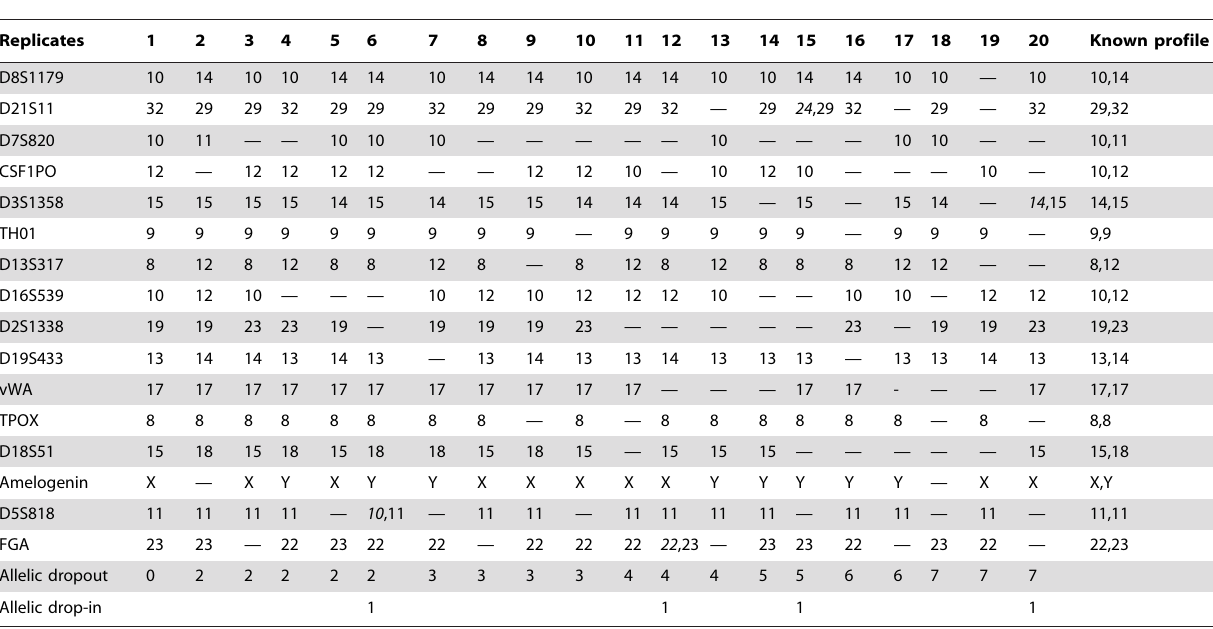
‘‘—’’ indicates allelic dropout. Italics indicate allelic